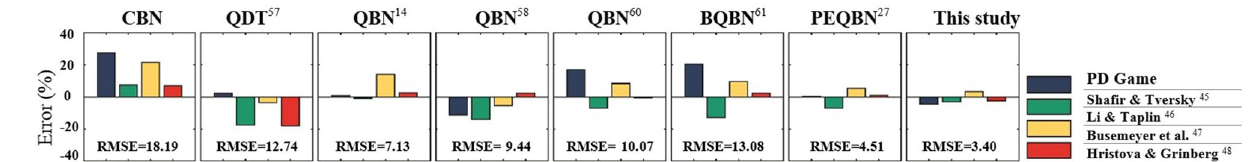
Figure 6. Graphical illustration of errors between empirical results (Table 1) and predicted values of Pr ( B = D ) . The results are obtained by applying seven models, including CBN, six recent quantum-like decision models, and the proposed BEQBN model in this study to the PD game.